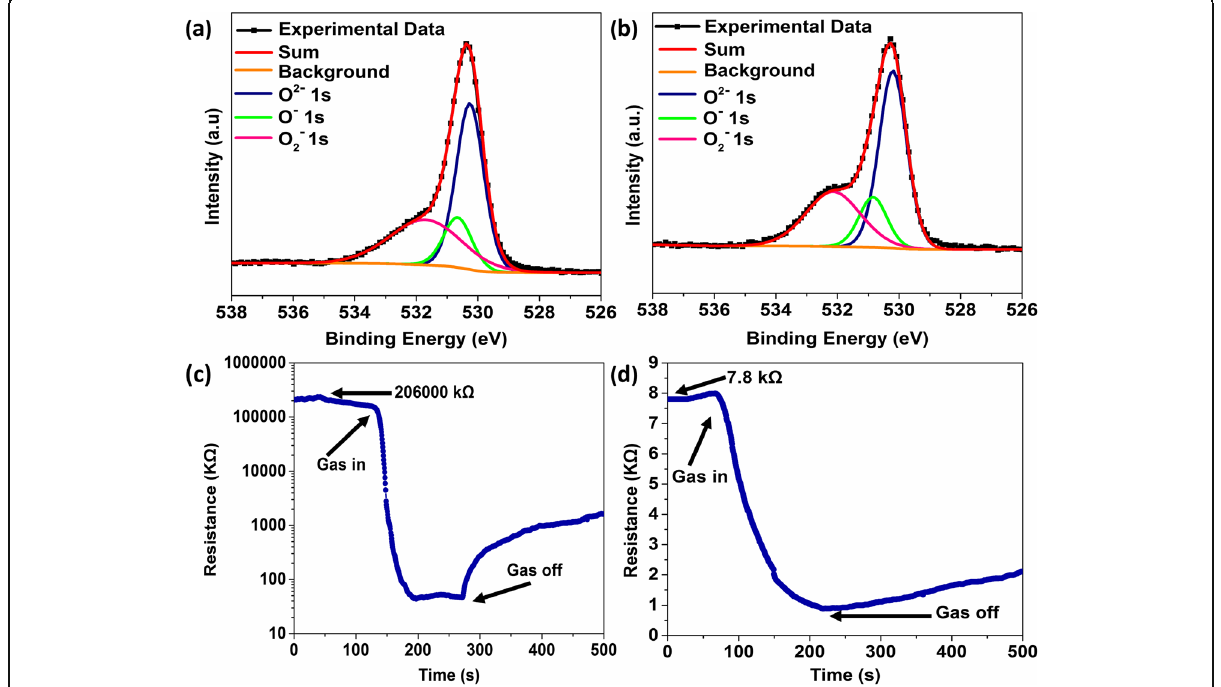
Fig. 12 XPS spectra of 5%Ag-In 2 O 3 ( a ) and pure In 2 O 3 ( b ) in the vicinity of O1s. Dynamic resistance transition characteristics of the 5%Ag-In 2 O 3 ( c ) and pure In 2 O 3 ( d ) toward 40 ppm of formaldehyde at 30